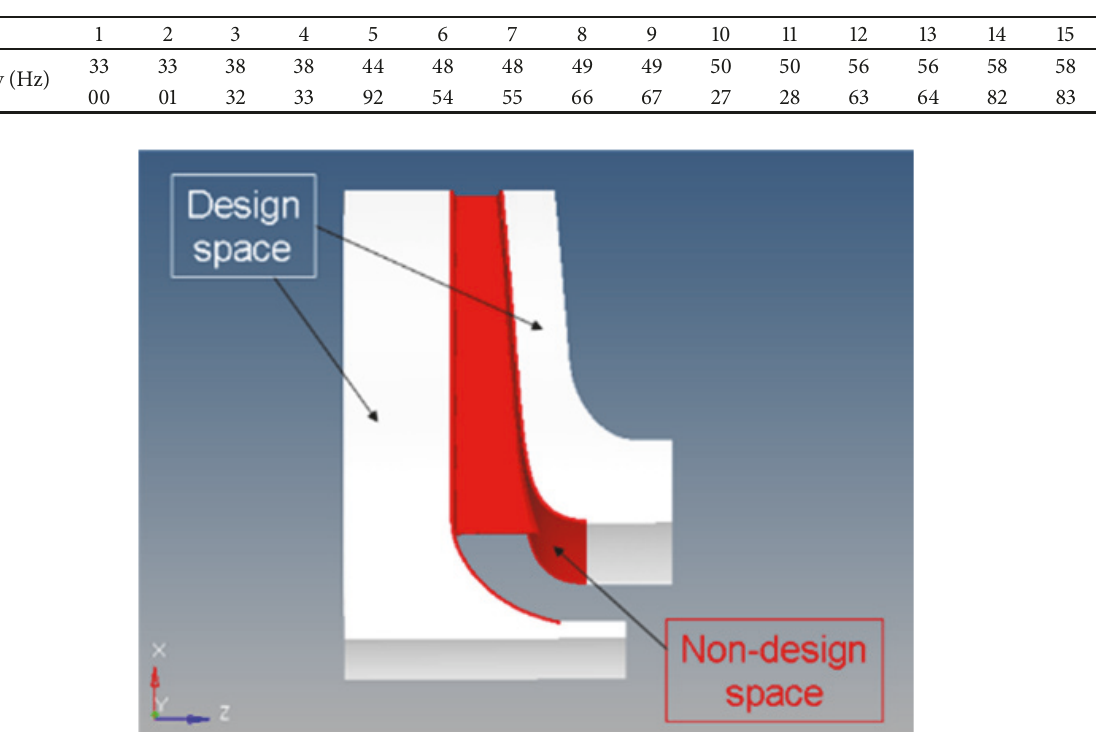
Figure 6: TO domain: design and nondesign